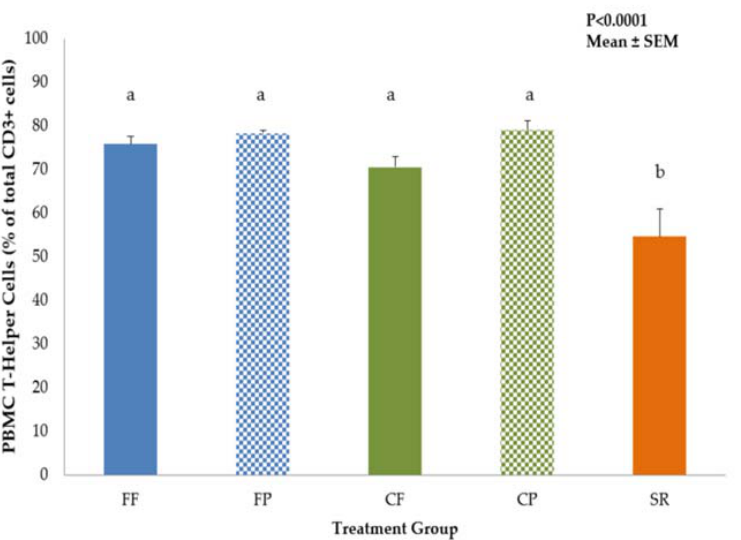
Figure 2. T-helper cells in PBMC of 21-day-old piglets fed different diets. SR had significantly lower percentages of circulating T-helper (CD3 + /CD4 + /CD8 − ) cells compared to all other diet groups. Values are mean ± SEM. Bars with different superscripts (e.g., a vs. b) indicate statistical significance at p < 0.05. Abbreviations: FF, formula-fed ( n = 5); FP, formula+prebiotic ( n = 7); CF, combination-fed ( n = 8); CP combination-fed+prebiotic ( n = 8); SR, sow-reared ( n = 9).